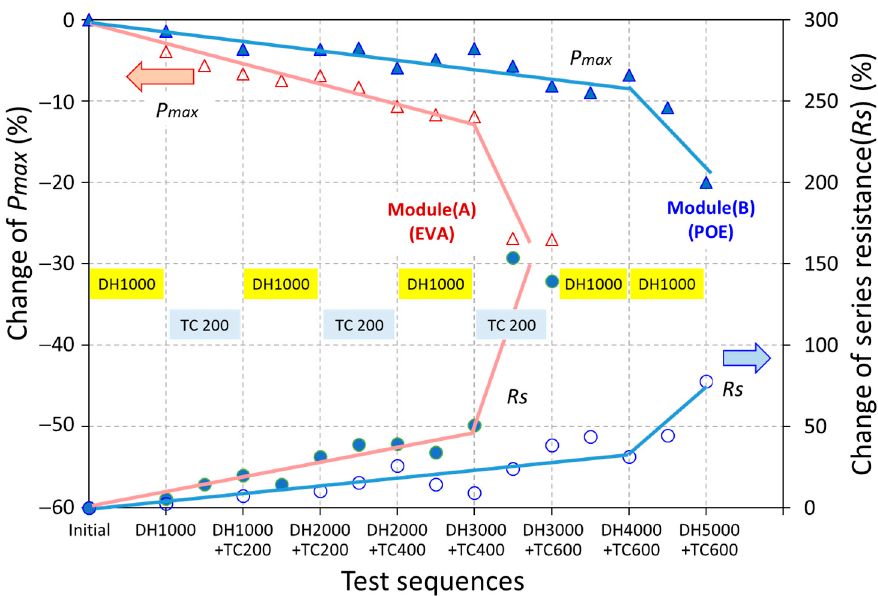
Figure 10. Changes in maximum output power ( Pmax ) and series resistance ( Rs ) with respect to combined DH5000-TC600 test sequences for two different modules, (A) with EVA and (B) with POE.